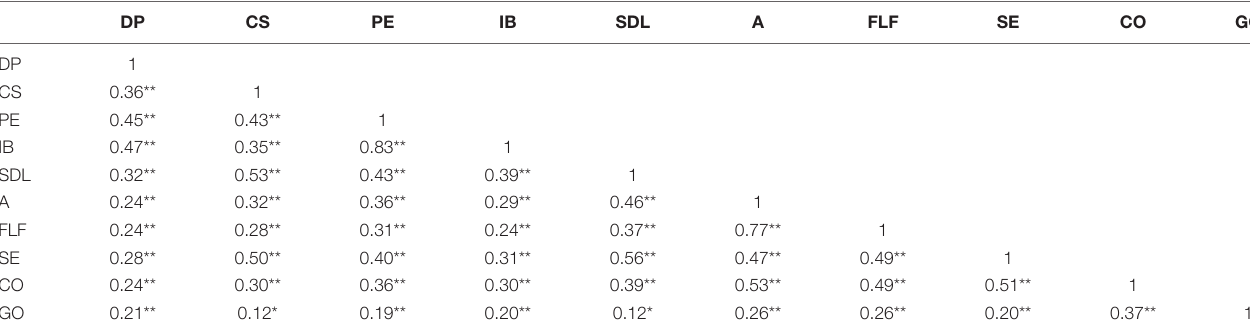
TABLE 1 | Correlations between Flipped English learning readiness variables and instructional practices, learning self-efficacy, and learning